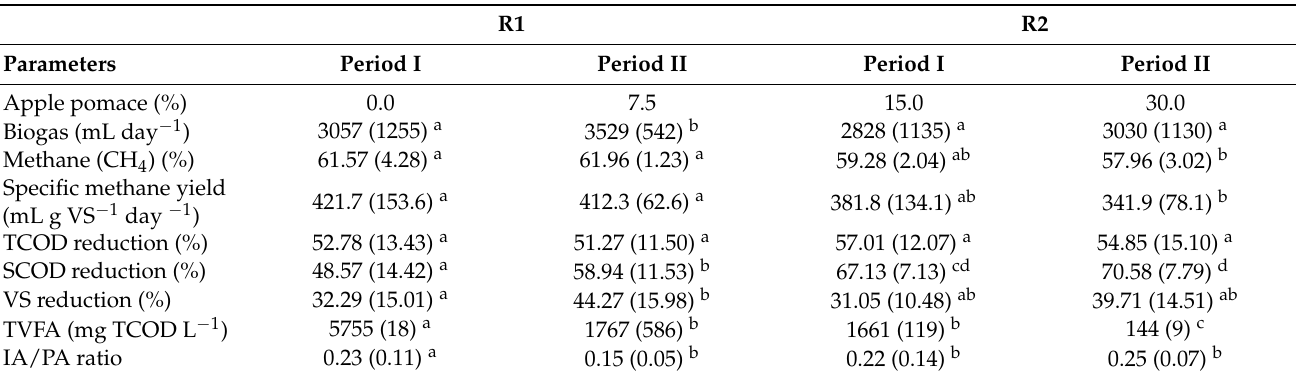
Table 2. Performance of AD treatment of four mixtures of SM and AP. Standard deviations are shown in parenthesis, followed by the descriptive coefficients indicating the statistically significant differences. The means within each parameter (horizontal) followed by different letters represent significant differences ( p < 0.05). R1